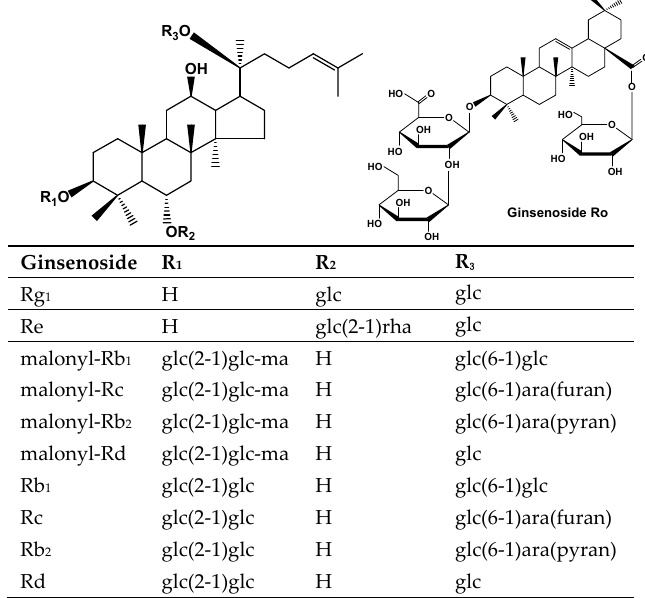
Figure 1. Structures of ginsenosides from Panax ginseng root. glc—glucosyl; ma—malonyl; ara— arabinosyl;